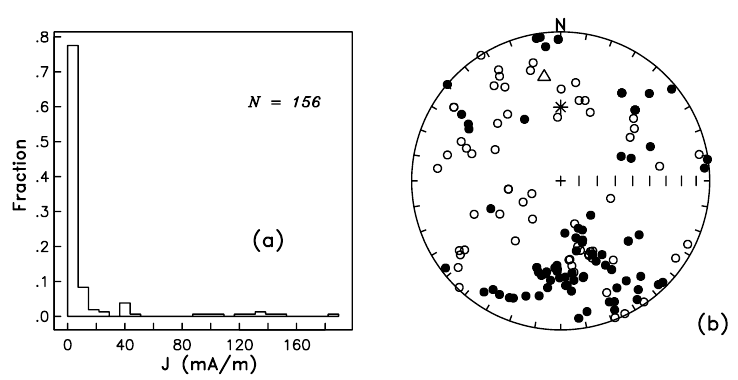
Fig. 2 – (a) Distribution of the NRM, and (b) equal area projection of NRM directions of 156 samples of the Botucatu Formation. Solid (open) circles represent positive (negative) magnetic inclinations, triangle is the present day geomagnetic field direction in the sampling area, and star is the axial dipole direction.